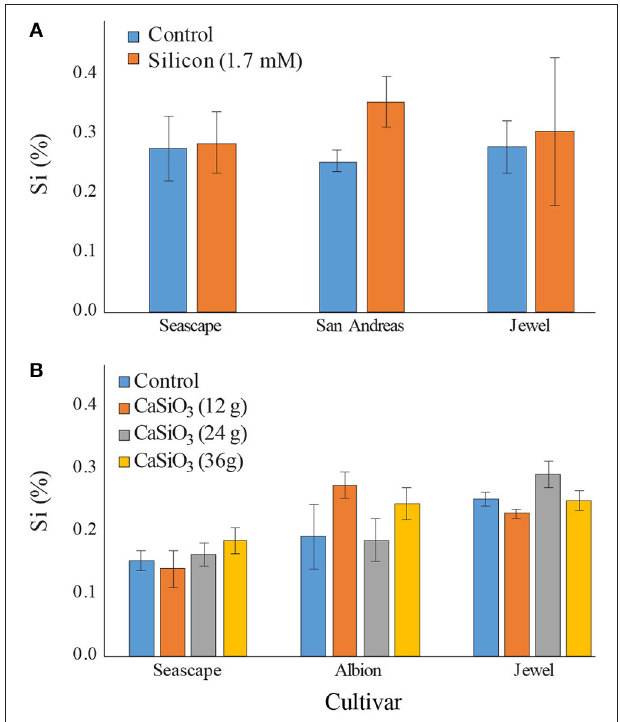
FIGURE 4 | Percent average silicon (Si) content in leaves of strawberry plants grown in field (A) treated twice a week with a 1.7 mM Si solution in summer 2015 (B) or fertilized with different concentrations of calcium silicate (wollastonite) in summer 2016. Sampling was made in September for both experiments. Each value represents the mean ± SE ( n = 3 in 2015; n = 6 in